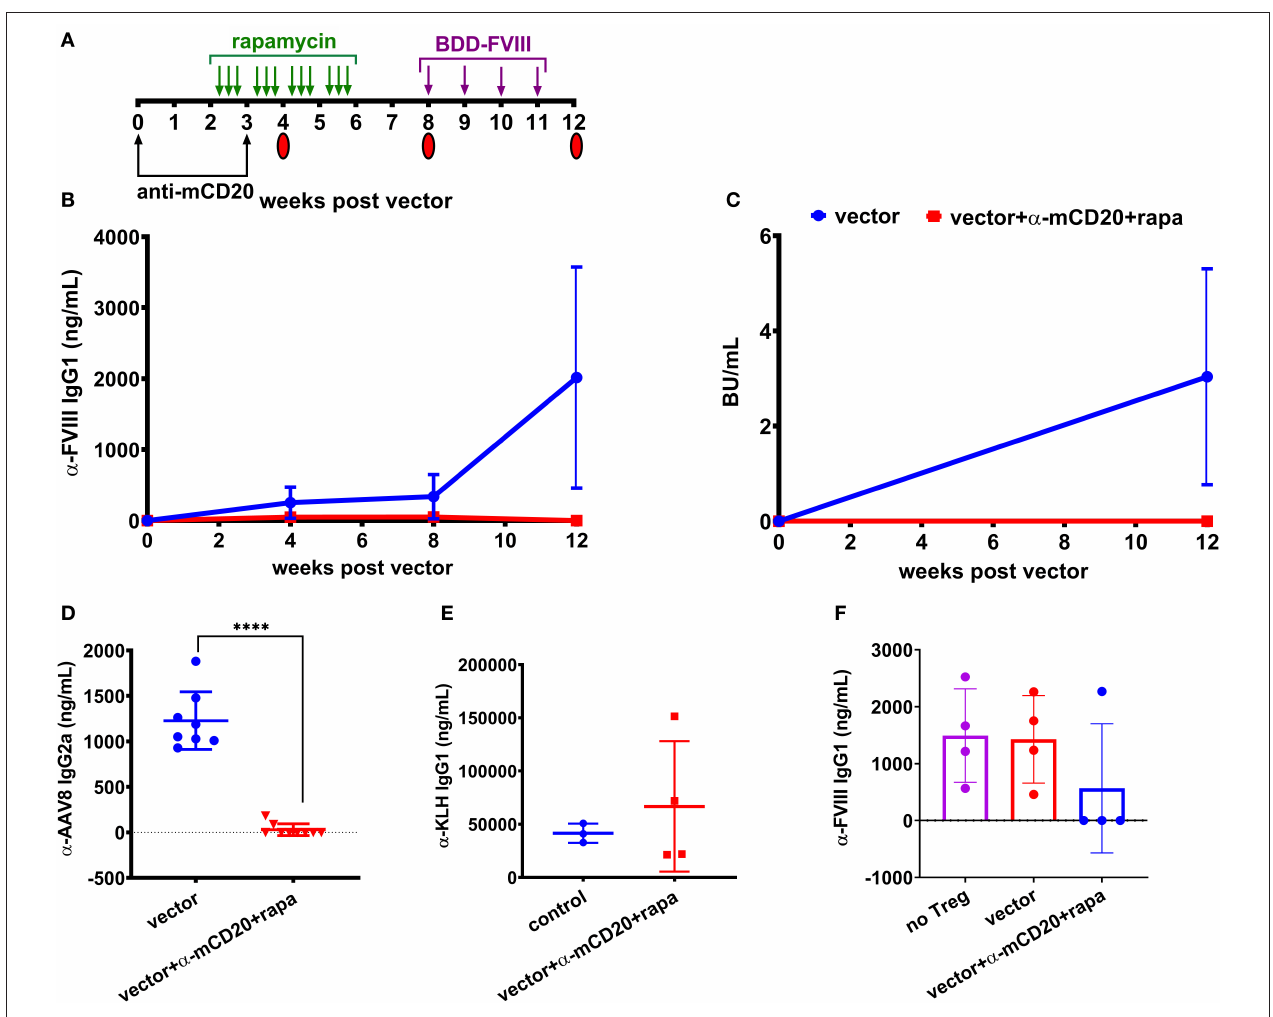
FIGURE 3 | Prophylactic immune suppression with anti-mCD20 and rapamycin prevents inhibitors following AAV8- coF8 gene delivery in BALB/c-HA mice. BALB/c-HA mice were divided into two groups ( n = 8 per group), control (blue) and anti-mCD20 plus rapamycin treated (red). (A) Both groups were IV injected with 1 × 10 11 vg AAV8- coF8 vector as indicated in the experimental timeline. Mice receiving immune suppression received anti-mCD20 along with vector and 3 weeks later. Oral gavage of rapamycin was started 2 weeks after vector, three times per week for 4 weeks. Mice received weekly IV injections of 1.5 IU FVIII starting at week 8 for 4 weeks. Mice were followed over time for anti-FVIII IgG1 levels (B) , and Bethesda inhibitor titers (C) . Plasma from mice at 8 weeks post-vector was used to measure anti-AAV8 IgG2a antibody levels by ELISA (D) . The surviving mice AAV only ( n = 3) and AAV with immunosuppression ( n = 4) were challenged with KLH to show that the transient immunosuppression did not compromise adaptive immunity and anti-KLH IgG1 levels were measured by ELISA (E) . Treg were isolated from four mice in each treatment group and 1 × 10 6 Tregs were adoptively transferred into naïve BALB/c-HA mice and the next day mice (Treg transfer and naïve controls) were challenged with subcutaneous delivery of 1.5 IU FVIII protein in adjuvant and bled 2 weeks later to measure anti-FVII IgG1 antibody levels by ELISA (F) . Statistical analysis of (D) was performed using unpaired T -test with **** p <